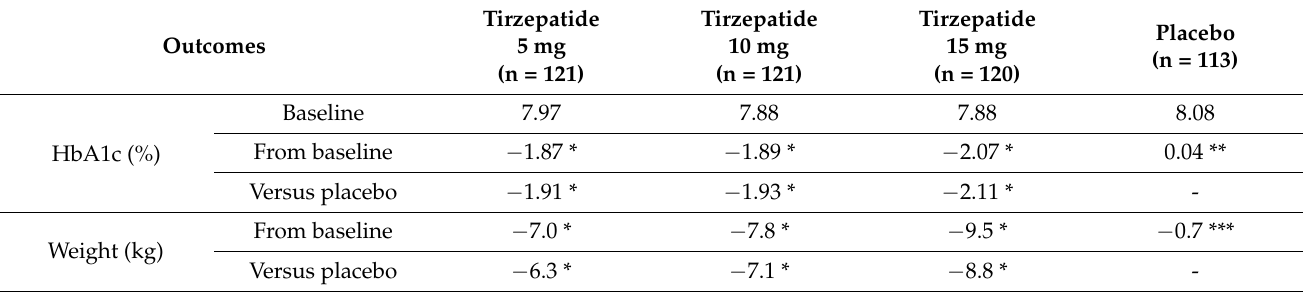
Table 1. Results of the SURPASS-1 trial at 40 weeks [26]. Efficacy analyses were performed in the modified intention-to-treat (mITT) population, which includes all randomized participants receiving at least one treatment dose; * p < 0.0001; ** p = 0.72; *** p = 0.22.